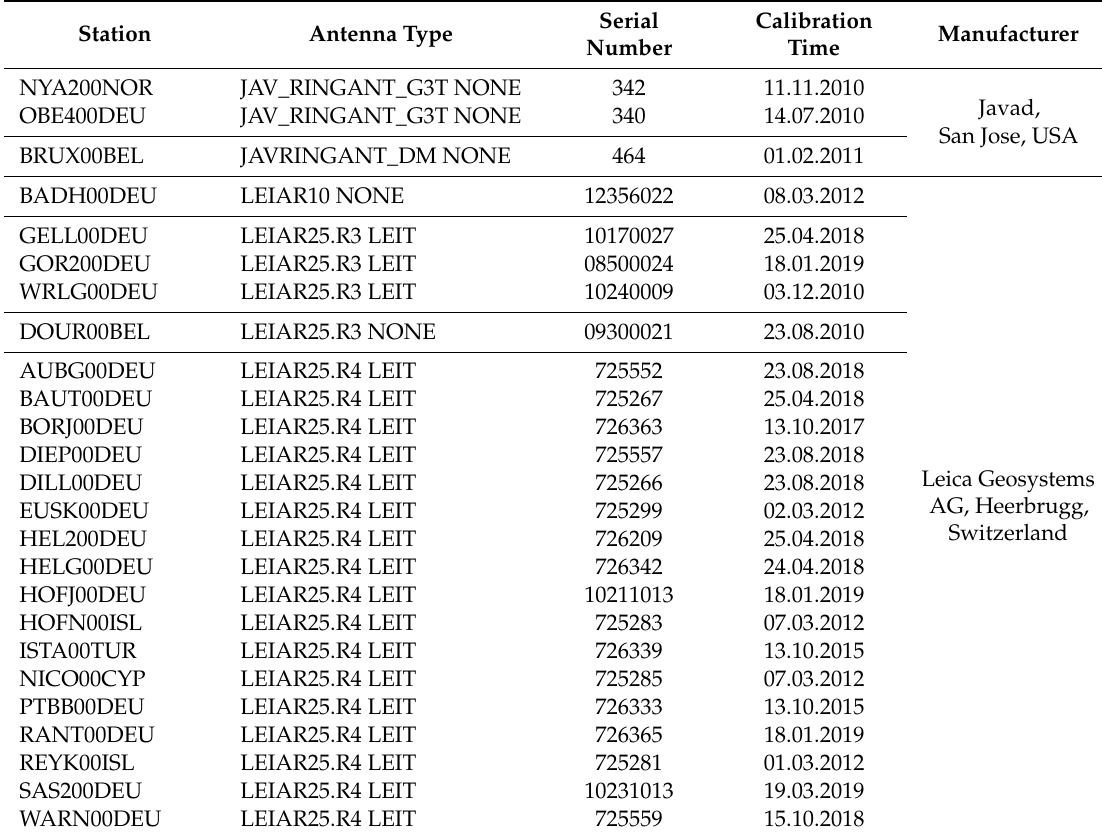
Table 2. List of the EUREF Permanent GNSS Network (EPN) stations equipped with antennas calibrated by the University of Bonn. The calibration tables for the listed stations contain at least G01, G02, E01 and E05 corrections.